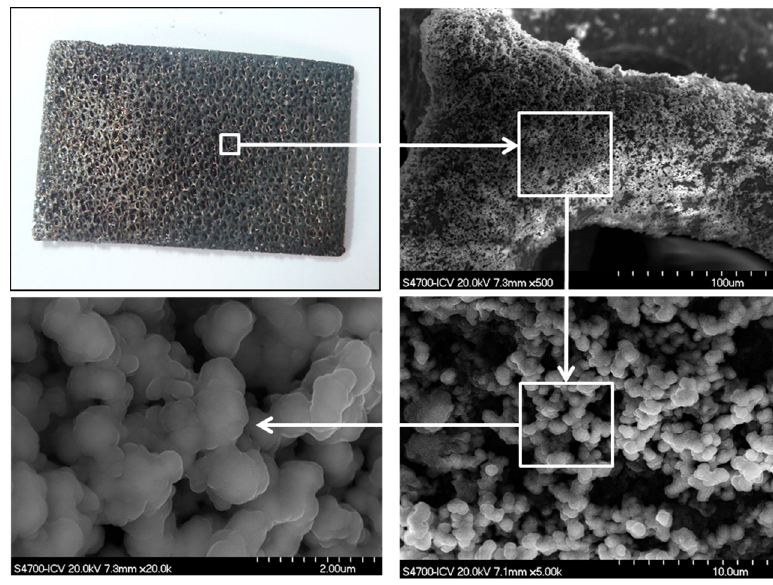
Figure 5. Picture and Micrographs at different magnifications of a Nickel foam coated with NiO/Ni particles. Figure 5. Pictureand Micrographs atdifferent magnifications of aNickel foamcoated withNiO/Ni